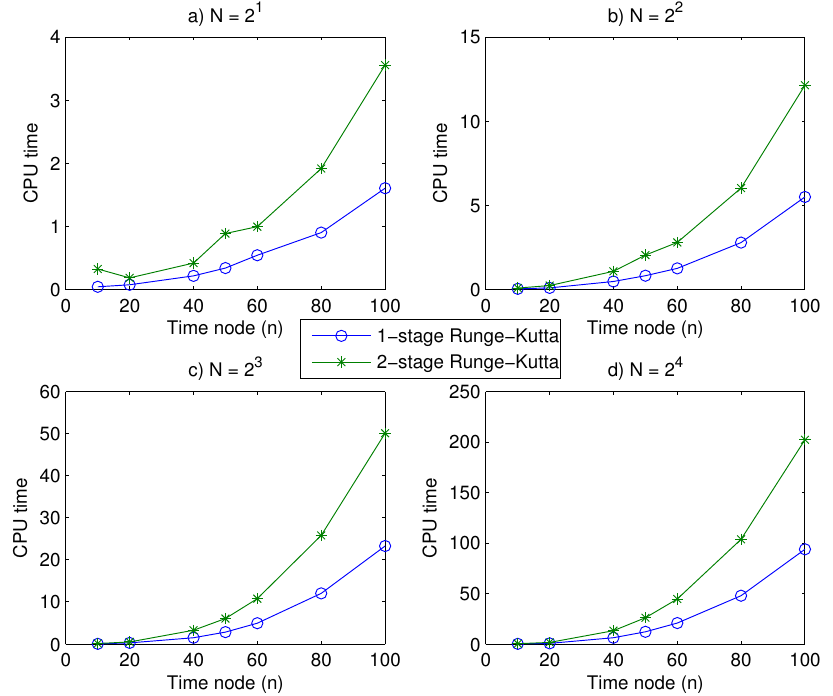
Figure 8. CPU time (in seconds) of Runge–Kutta